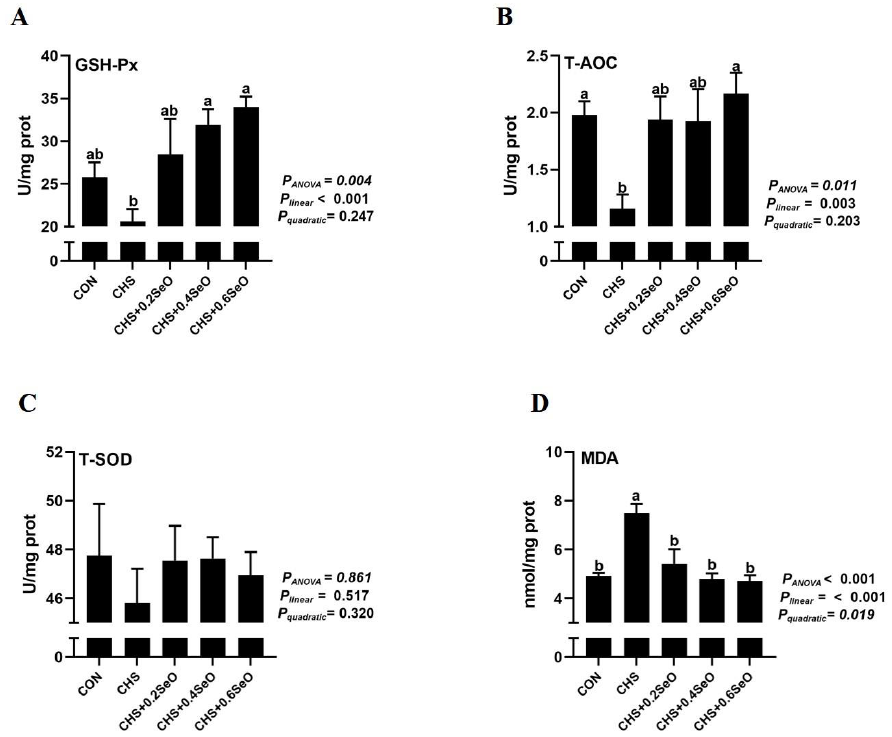
Figure 2. Effects of CHS and SeO supplementation on splenic antioxidant capacity of growing pigs. ( A ) GSH-Px, glutathione peroxidase; ( B ) T-AOC, total antioxidant capacity; ( C ) T-SOD, total superoxide dismutase; ( D ) MDA, malondialdehyde. The results were expressed as mean ± SEM ( n = 6). Different letters (a and b) denote significant differences, P ANOVA : p value of Analysis of Variance, P linear and P quadratic : p value of Orthogonal Polynomial Contrasts.